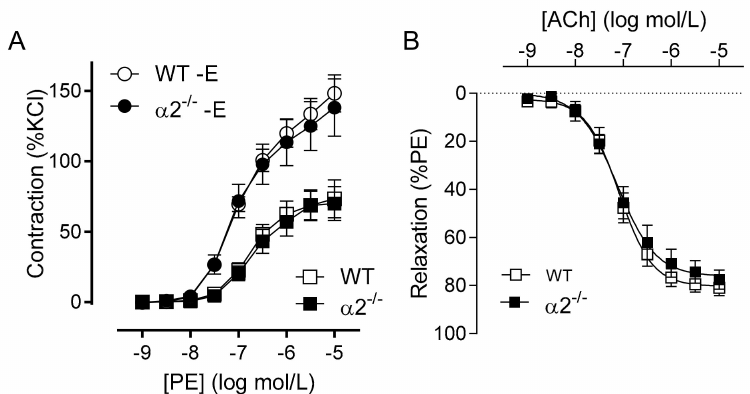
Figure 2. Consequences of global AMPK α 2 deletion on vascular reactivity. Vascular reactivity in aortic rings from wild-type (WT) and AMPK α 2 − / − ( α 2 − / − ) mice: ( A ) contractile response to phenylephrine (PE) in the presence and absence ( − E) of endothelium. ( B ) Concentration-dependent relaxation due to acetylcholine. The graphs summarize data obtained from seven animals in each